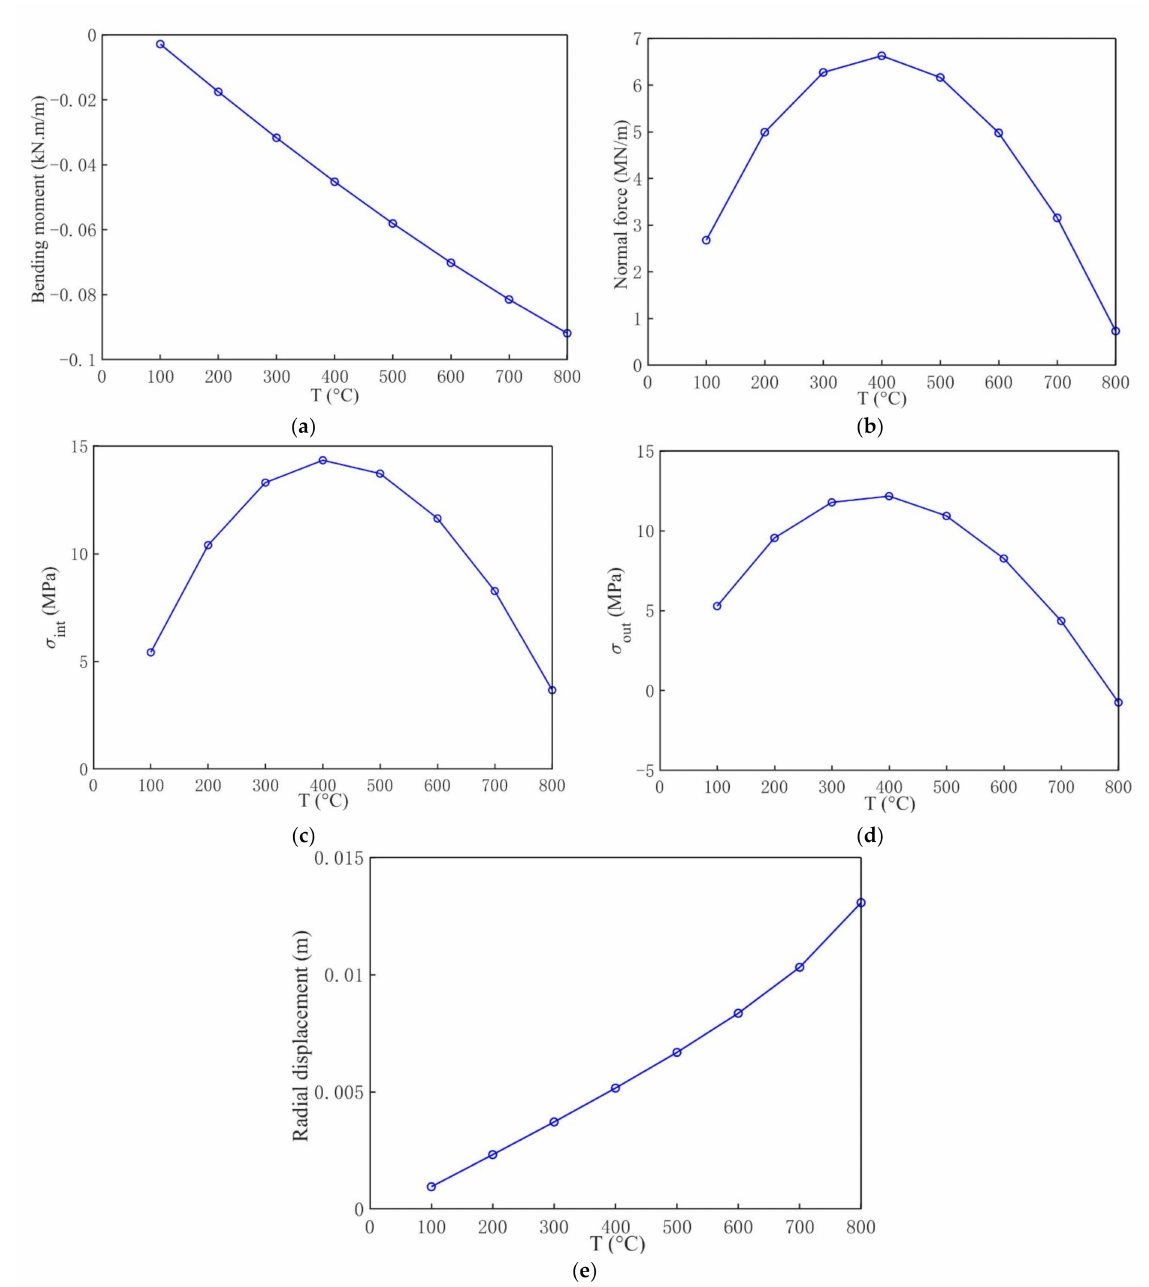
Figure 10. Impact of the temperature on the behavior of tunnel lining at the tunnel crown considering different α Tl : ( a ) Bending moment of lining; ( b ) Normal force of lining; ( c ) Intrados stress of lining; ( d ) Extrados stress of lining; ( e ) Radial displacement of